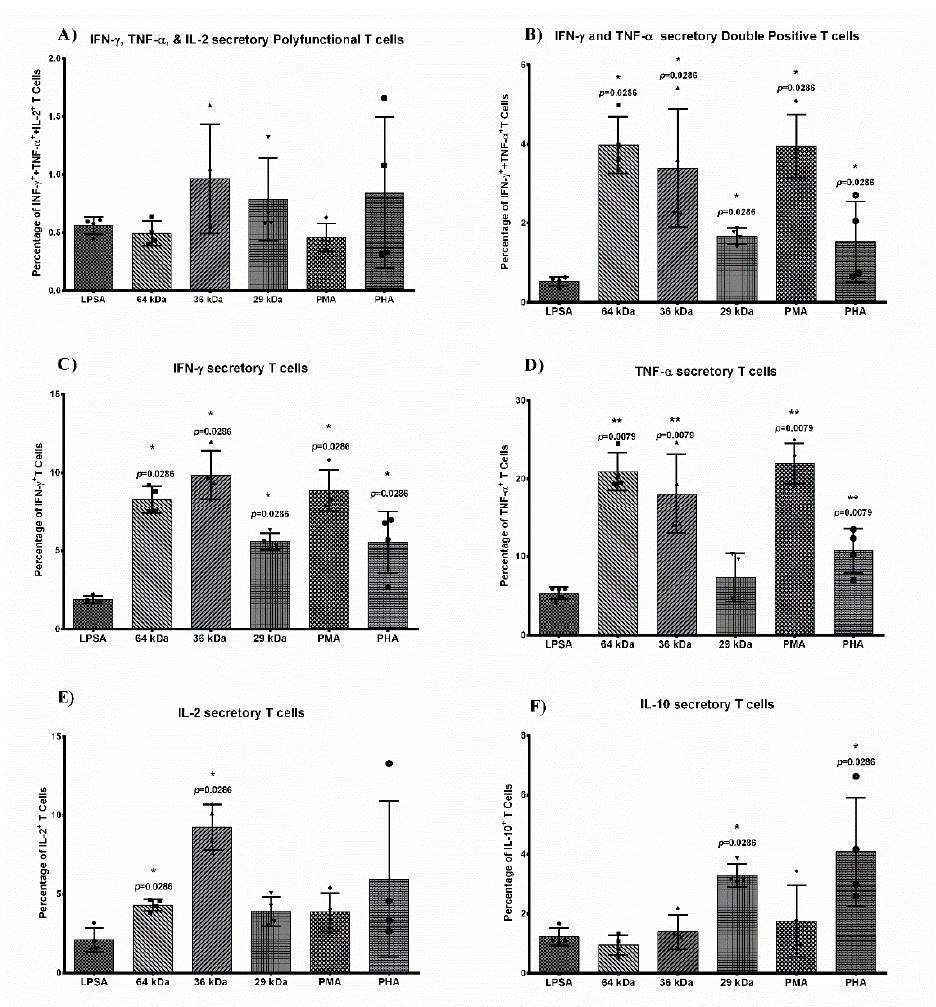
Figure 6. Bar graph comparing the frequency of CD3+ T cells secreting IFN- γ , TNF- α , IL-2, and IL-10. ( A ) Frequency of polyfunctional CD3+ T cells expressing IFN- γ , TNF- α , and IL-2 simultaneously. ( B ) Frequency of dual positive CD3+ T cells expressing IFN- γ and TNF- α simultaneously. ( C ) Frequency of CD3+ T cells expressing IFN- γ . ( D ) Frequency of CD3+ T cells expressing TNF- α . ( E ) Frequency of CD3+ T cells expressing IL-2. ( F ) Frequency of cells expressing IL-10. n = 4. Symbols for individual values, • LPSA, ■ 64 kDa, ▲ 36 kDa, ▼ 29 kDa, ♦ PMA & ● PHA. Mean values and SD. Statistical comparison between LPSA and test group. Student’s t -test. Level of significance, ns p > 0.05, * p ≤ 0.05, ** p ≤ 0.01.